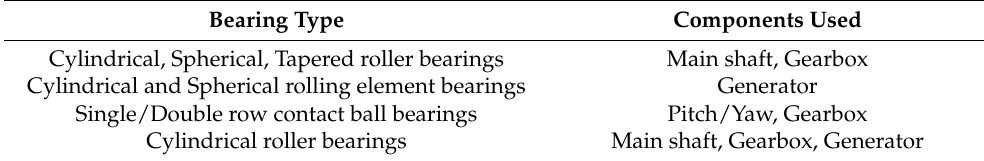
Table 2 summarizes the specific application of bearings in different parts of wind turbines. Table 2. Types of bearings for different sections (Adapted from